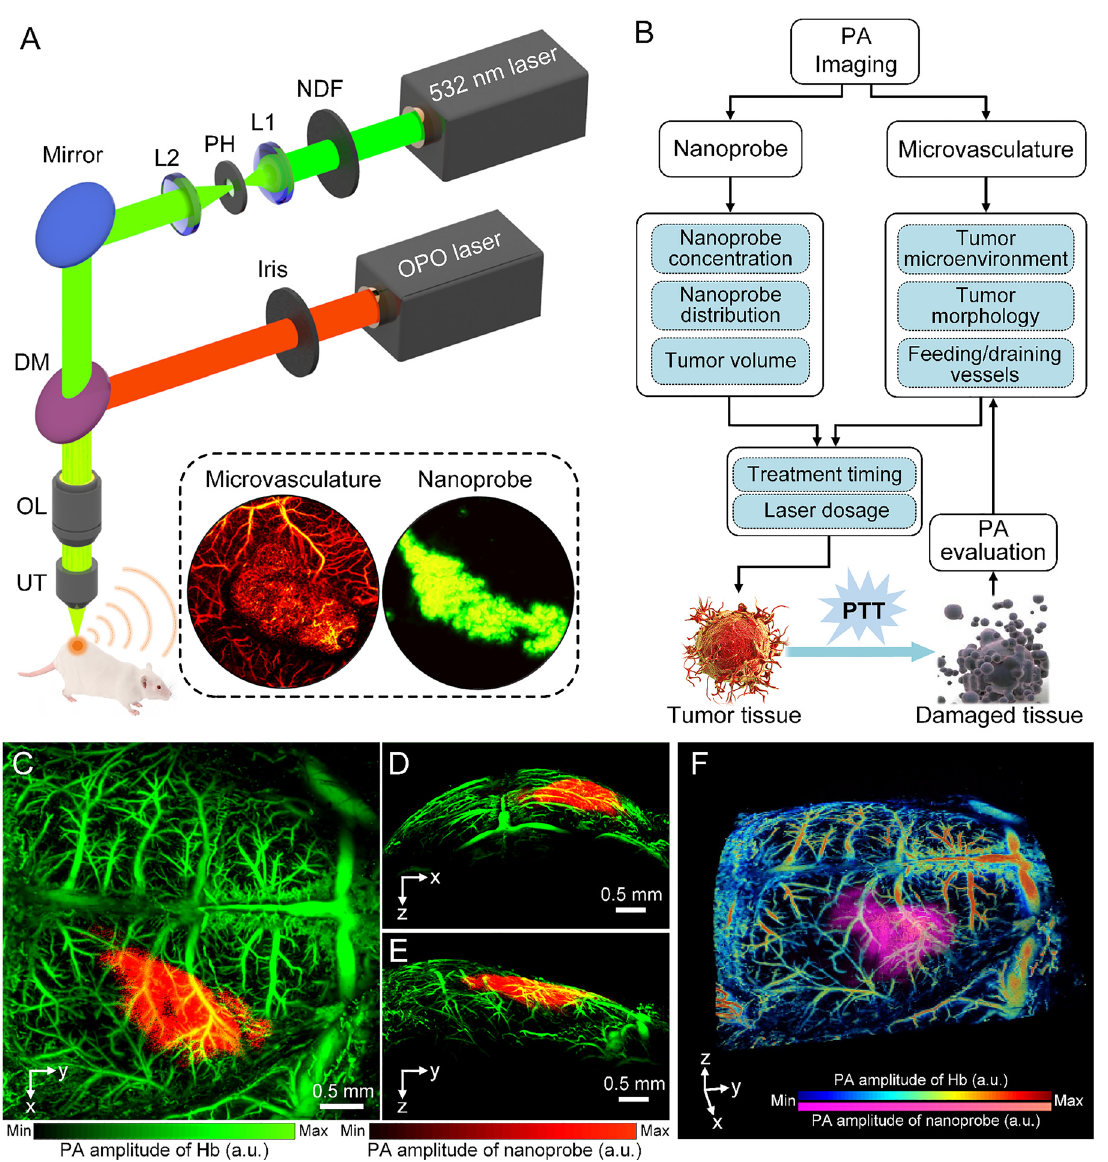
Figure 1: (A) The schematic diagram of the photoacoustic microscopysystem. (B) Guiding diagram of photoacoustic imaging in photothermal therapy. (C – E) The merged photoacoustic images of microvasculature and nanoparticles distribution in a complete mouse skull state. (F) 3D photoacoustic